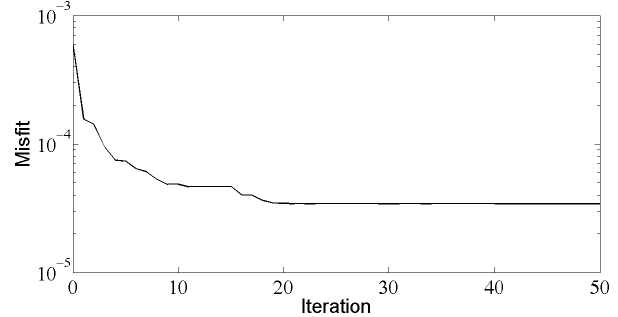
Figure 8. The misfit curve of 2D TM-mode inversion.